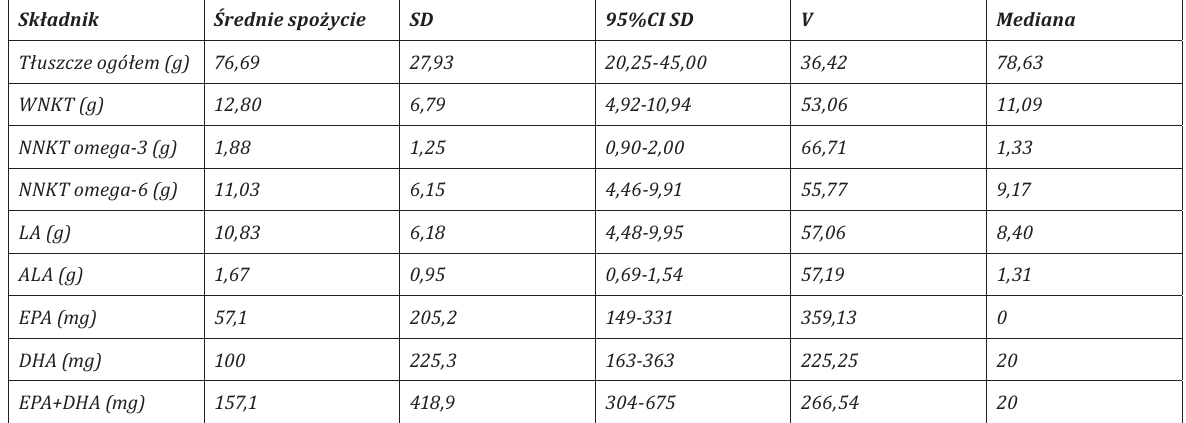
p-value – istotność statystyczna - kobiety vs mężczyźni, *p<0.05 Tabela 6. Spożycie tłuszczu w badanej populacji -